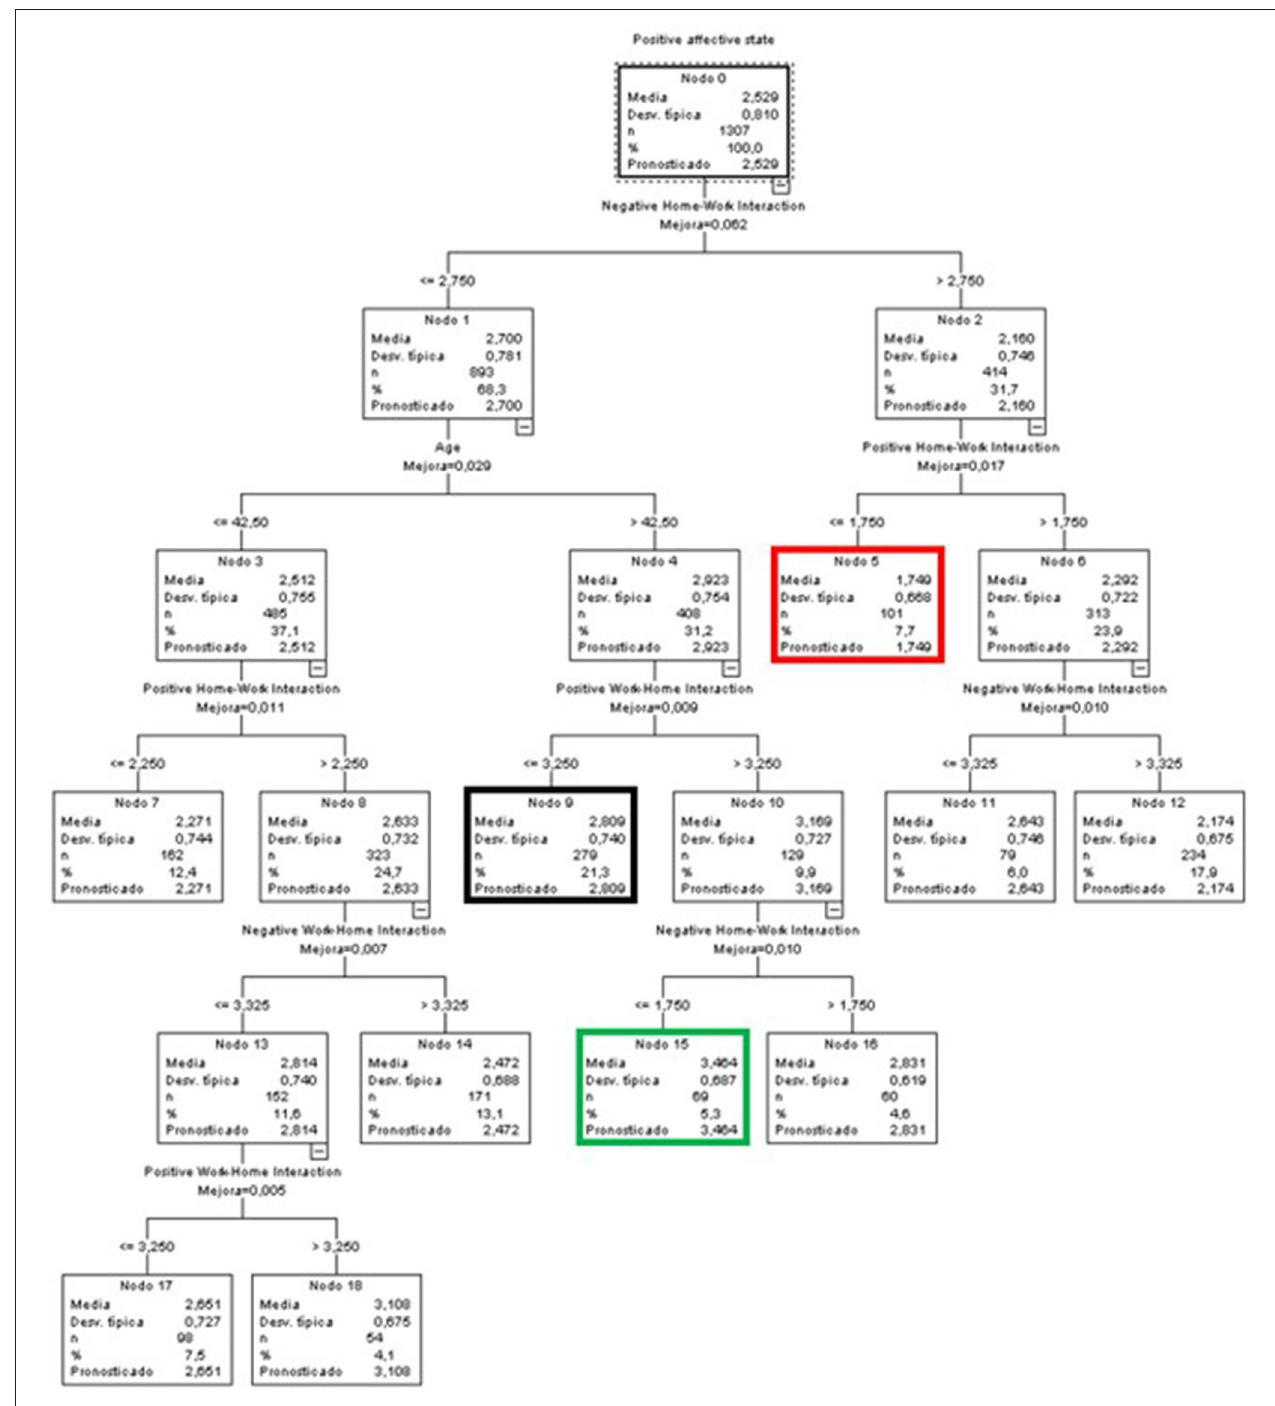
FIGURE 7 | Classificatory tree of positive affective states (Complete